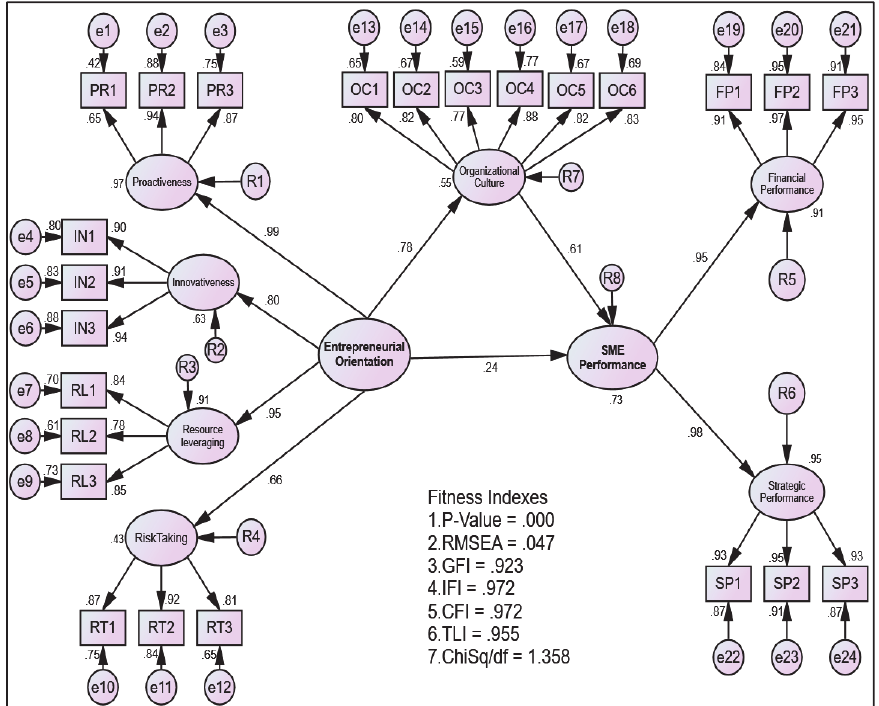
Fig. 3. Standardized Regression Weights for Every Path in the